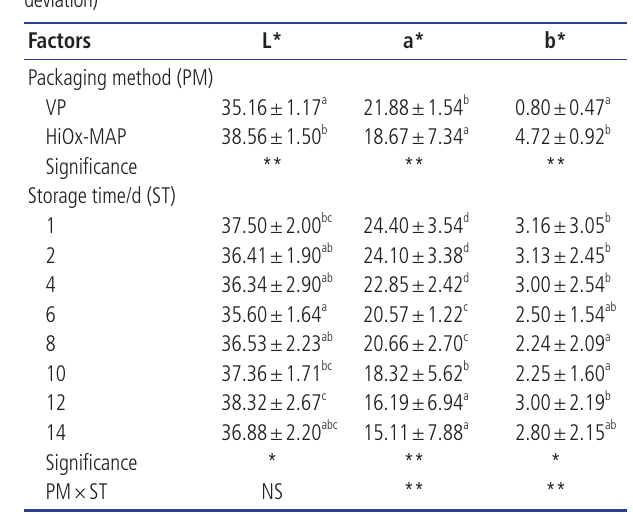
+20% CO ) on color (L*, a*, and b*) 2 2